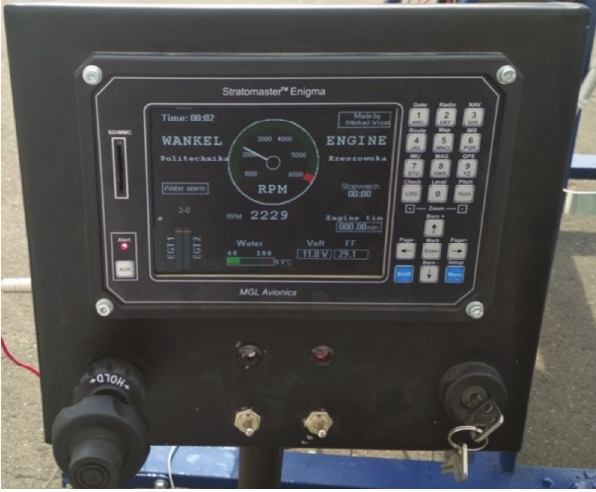
Fig. 7. Test stand – a panel used for reading engine operation parameters